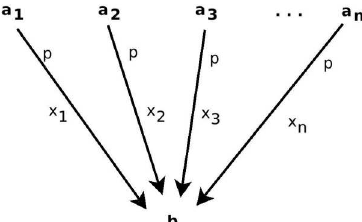
Figure 1. Structure of a convergent argument with initial strengths x 1 , . . . , x n and polarity p . Each arrow constitutes a basic argument for standpoint b , but